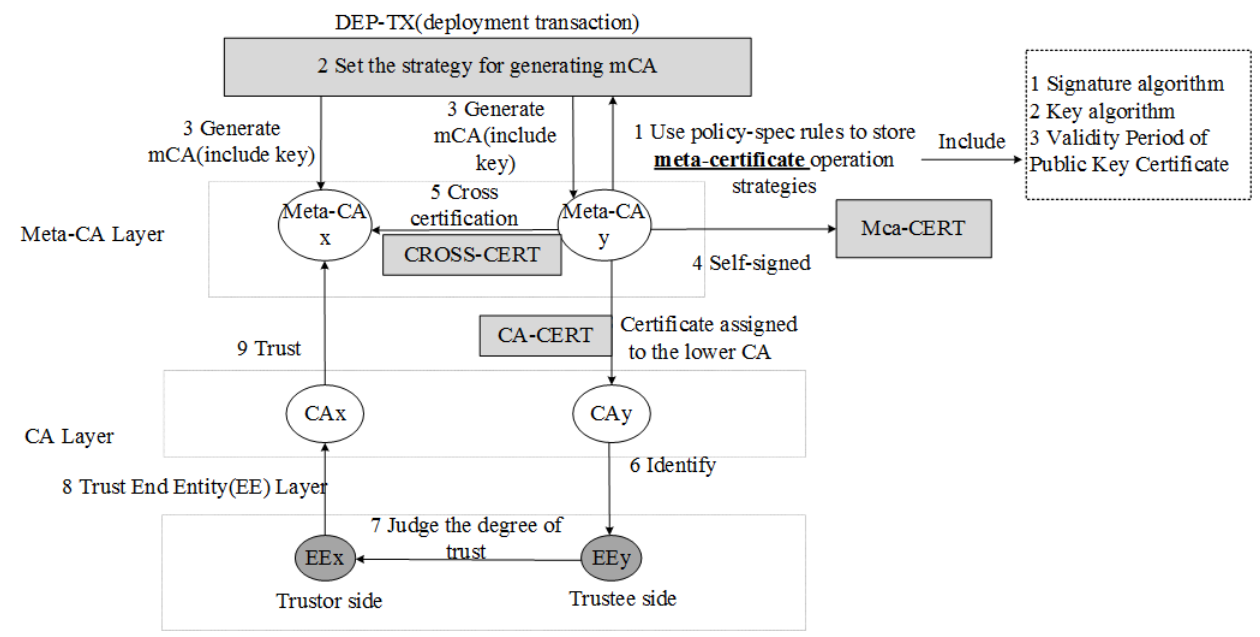
Figure 15. Reconstruction diagram of reference [38].